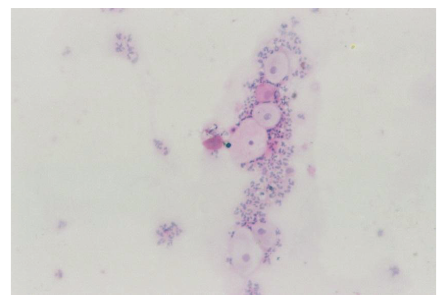
Figure 1: Superficial, intermediate, and parabasal epithelial cells (H&E, × 400).